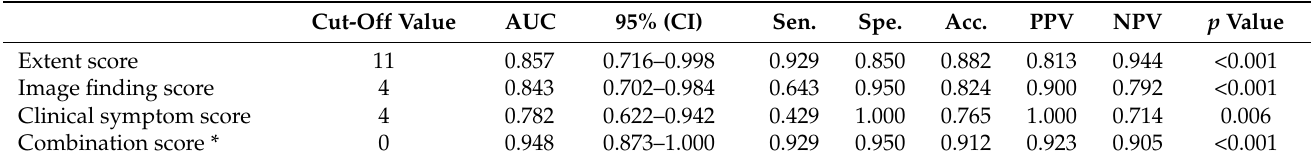
Table 3. Comparison of diagnostic performance among extent, image finding, clinical symptom, and the combination scores. AUC Sen.